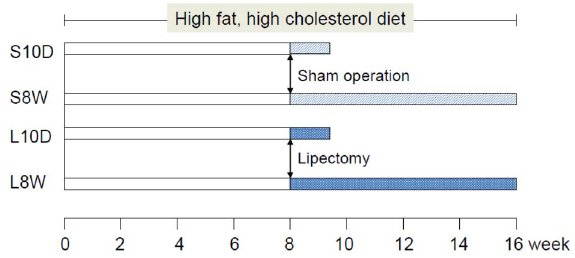
Figure 1. Experimental design and designation of group